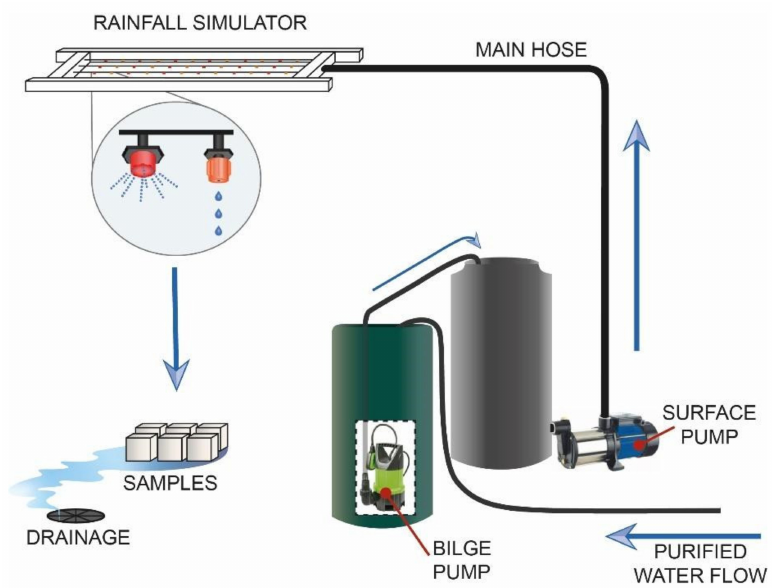
Figure 5. Simulator